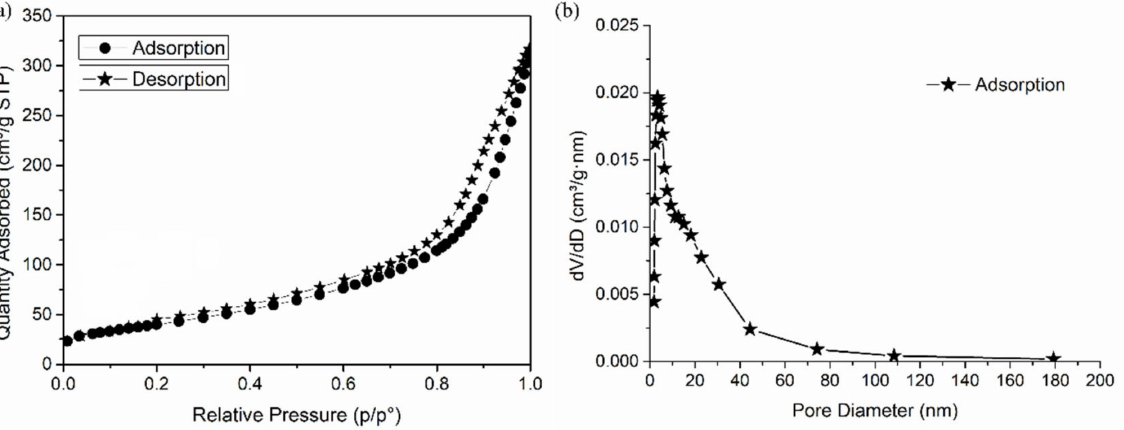
Figure 5. N 2 adsorption-desorption isotherms ( a ) and pore size distribution graphs ( b ) of HAp-CTAB